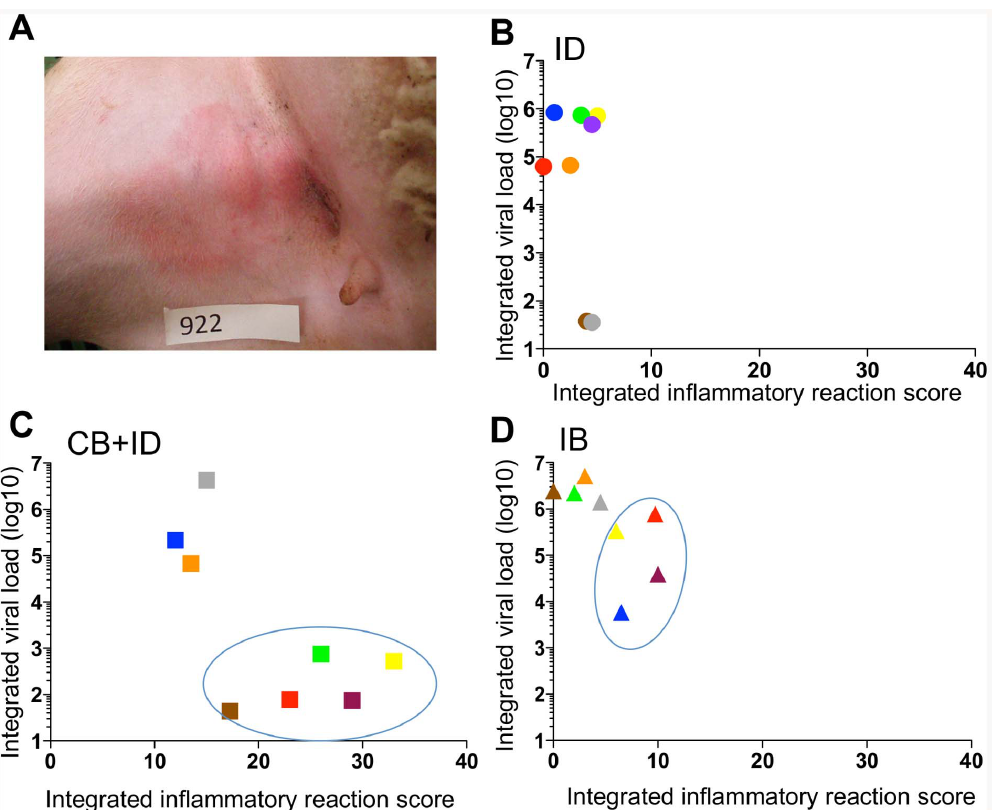
Figure 3. An elevated local inflammatory reaction appears associated to lower viraemia in C.nubeculosous- bitten sheep. A. A local inflammation at the inoculation point was observed especially in the CB + ID group, with an example of sheep 922 (score=3). B, C, D. The local inflammation of the inoculation points was monitored from 0 to 7 dpi (the scores from the right and left inguinal sides were added) and the calculated area under the curve for each sheep is reported with the same color and shape symbol as in Fig. 1. B: ID group, C: CB + ID group, D: IB group. The sheep with higher inflammation and lower viral loads in the CB + ID and IB groups are circled.